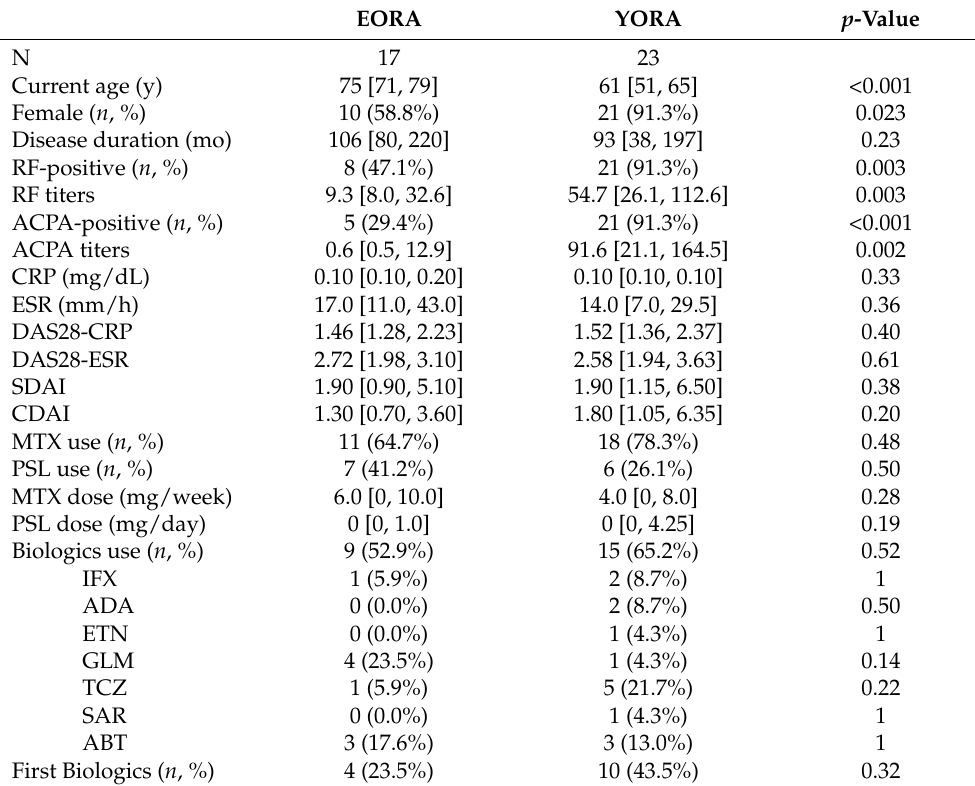
Table 1. Comparison of clinical characteristics between elderly-onset and young-onset rheuma- toid arthritis.